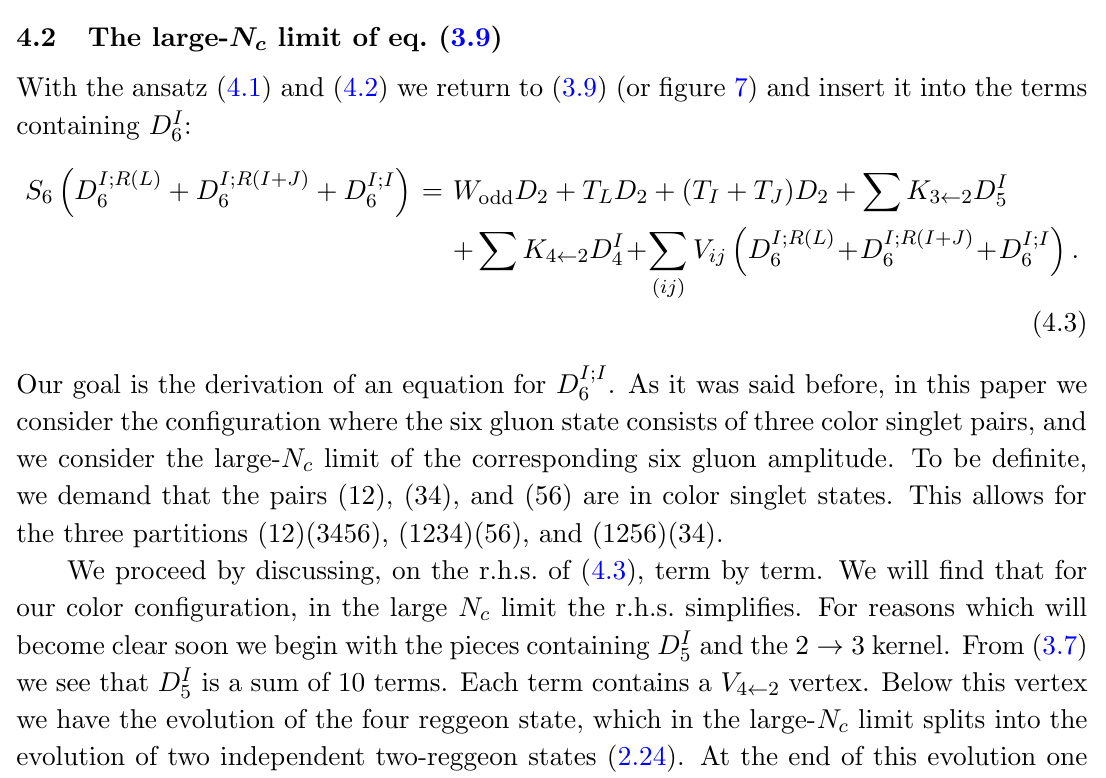
Figure 8 . Reggeizing pieces of the second reduction, D I ; R (cid:12)gure 6, the pairs of straight lines at the lower end of reggeized gluons indicate that they depend upon the sum of momenta and (cid:12)nally decay into two gluons. Further details are described in section